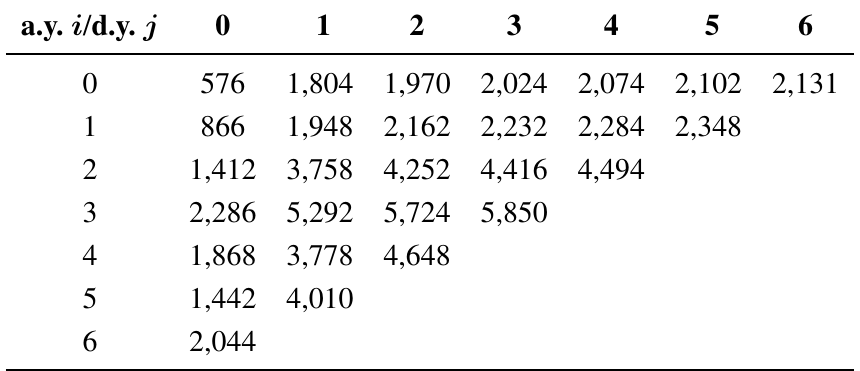
, i + j ≤ 6 , source Quarg and Mack [1]. i,j